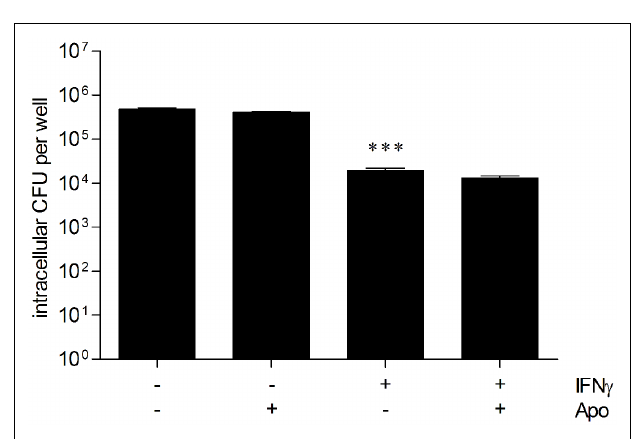
FIGURE 7 | Scavengers/inhibitors of reactive oxygen intermediates do not inhibit the antibacterial activity of hepatocytes. Intracellular survival of B. pseudomallei E8 24h after infection (MOI 42:1) of unstimulated and IFN γ -stimulated (500ng/ml) HepG2 cells in the presence of antioxidants superoxide dismutase (SOD, 20U/ml), catalase (CAT, 200U/ml), and N -acetyl-cysteine (NAC, 200 μ M). Data are presented as mean with SEM of triplicate determinations. One representative experiment out of three independent experiments is shown. Statistical analyses were performed using a Student’s t